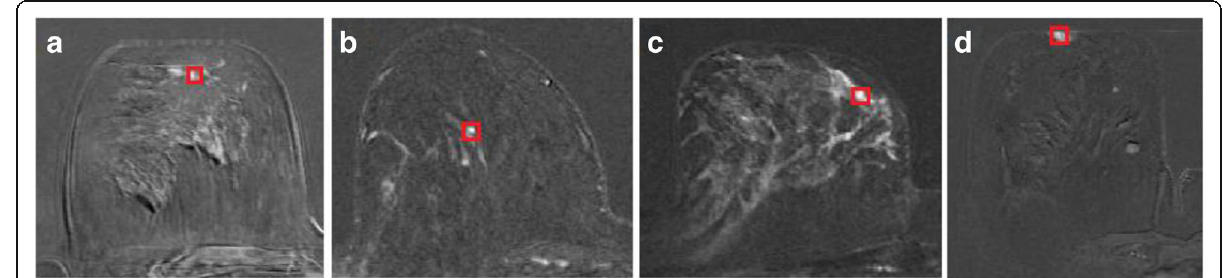
Fig. 12 False positive detections on the subtracted images for four different normal cases. a - c Three normal cases without breast lesions, there are contrast enhancement in fibroglandular tissues because of injection of contrast agent, and d a normal case without breast lesion, there is contrast enhancement in the nipple because of injection of contrast agent. The squared markers refer to the potential lesion voxels obtained by the presented method. Due to small diameter of false positive detections, the connected component boundaries are shown very unnoticeable. For such cases, only the region that the potential legion voxels are located, are demonstratd on the figures